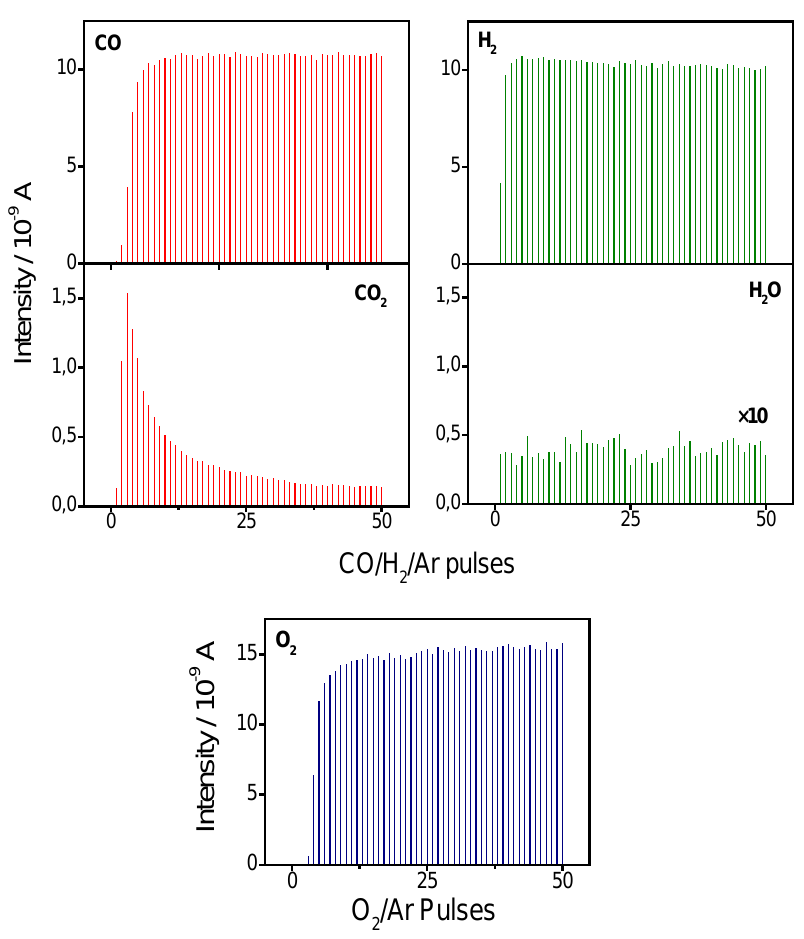
Figure 1. Mass spectrometer signals of CO, CO 2 , H 2 , and H 2 O measured during a sequence of CO/H 2 /Ar pulses (CO/H 2 ratio = 1/2) on Au/TiO 2 at 80 °C after oxidation by O 2 /Ar pulses, as well as the O 2 signal measured during subsequent O 2 /Ar pulses at 80 °C.